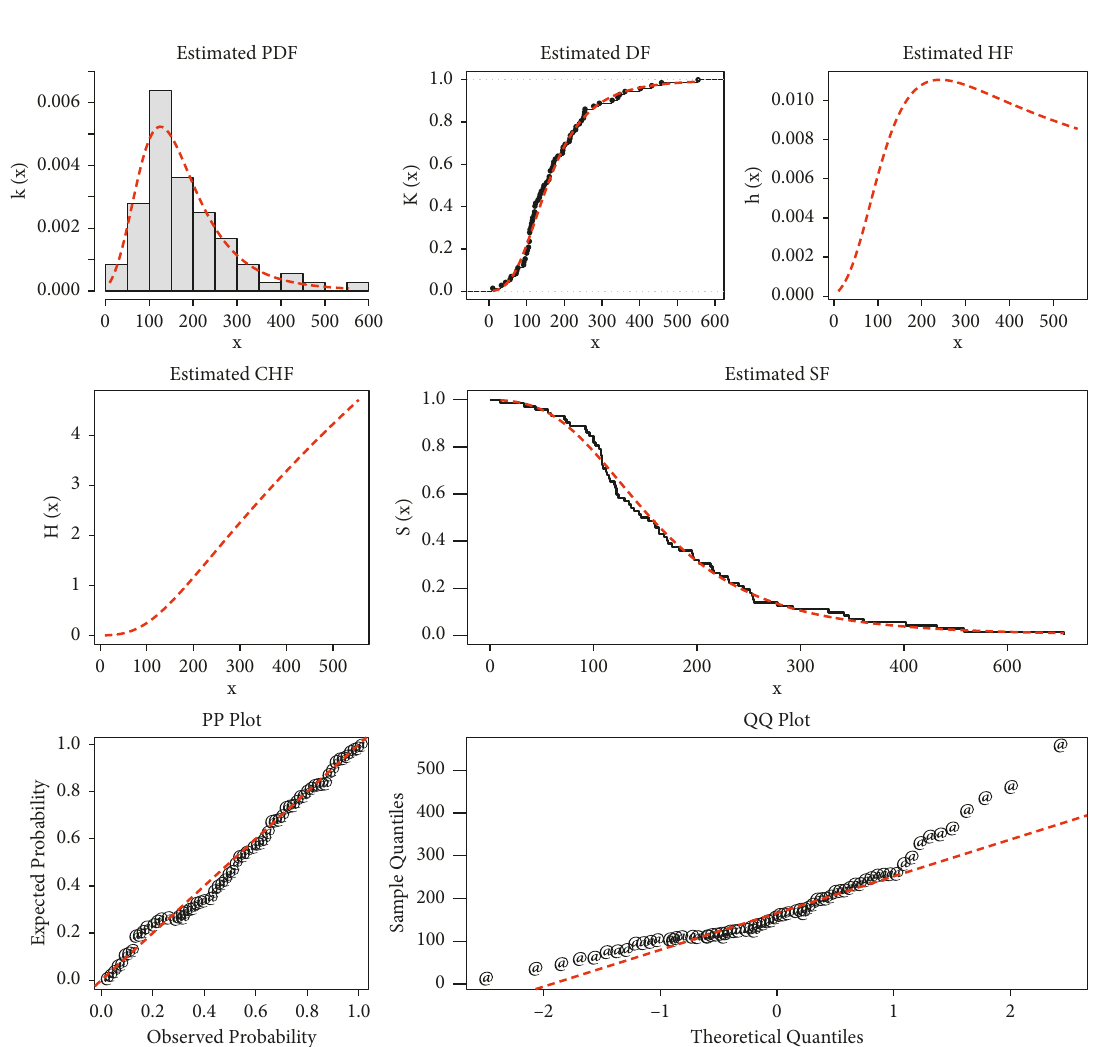
Figure 9: Visual illustration of the NFLog-Wei distribution using Data 2.